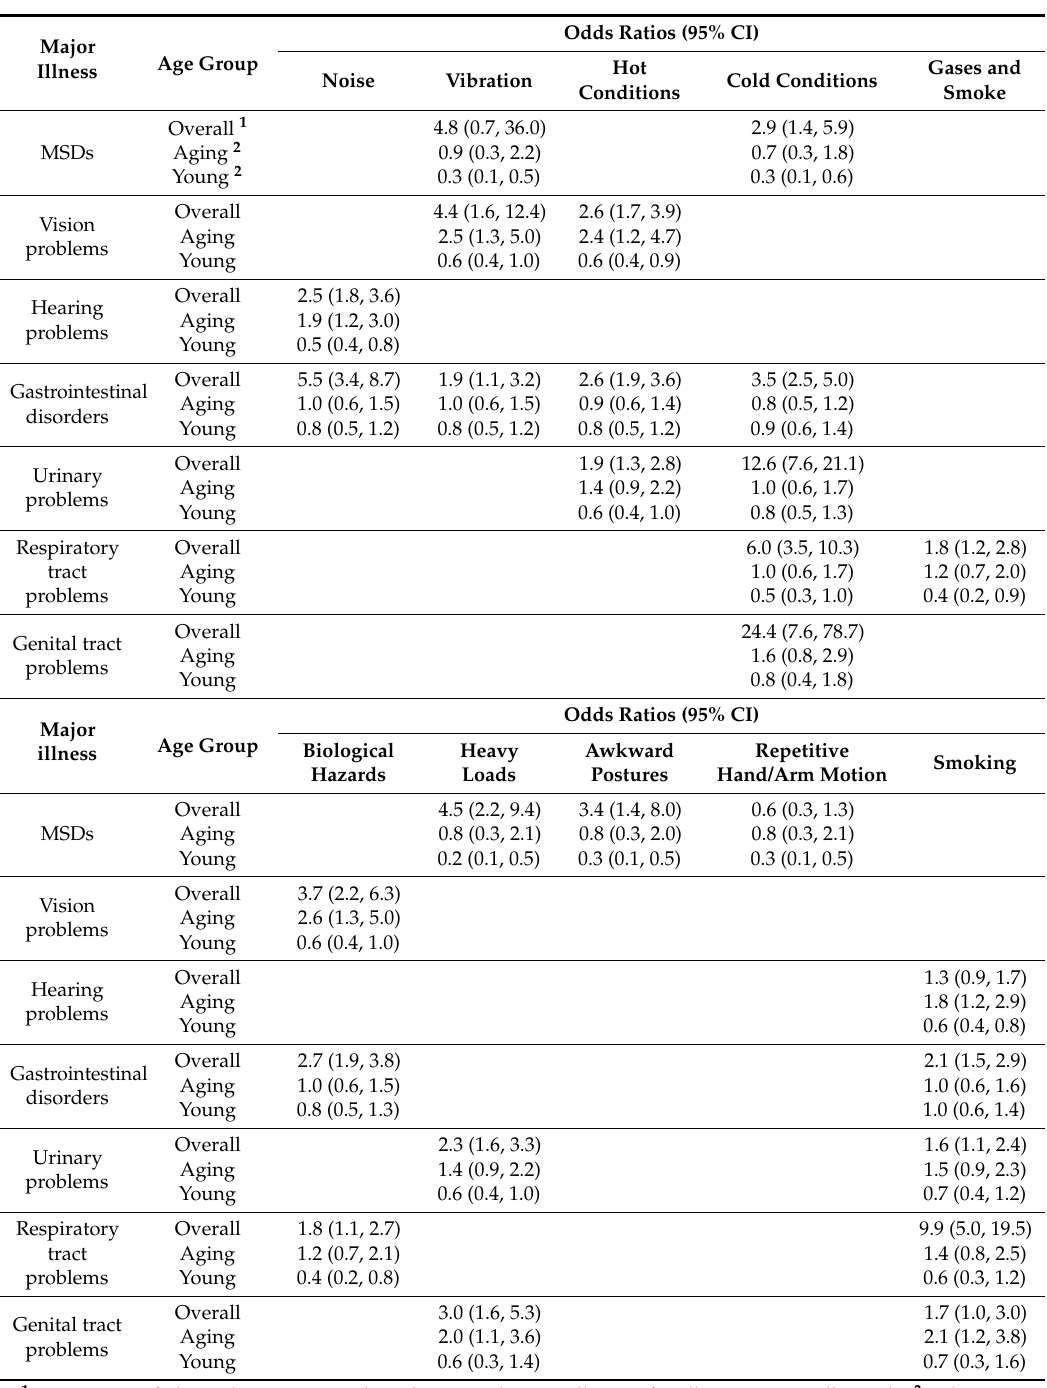
Table 4. Logistic regression analysis of the association of both age group and physical environmental conditions (as predictors) with major self-reported illnesses (as response) (only important associations are displayed for table simplicity and